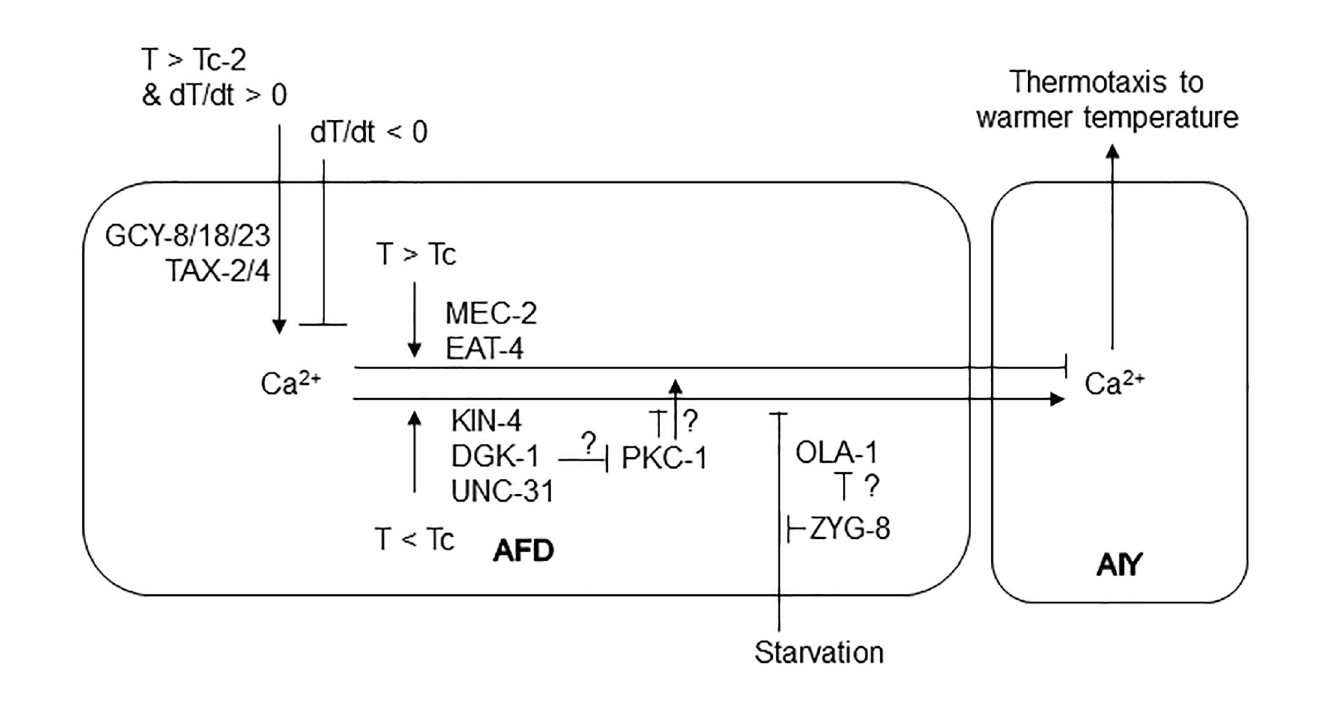
Fig 9. Mechanisms underlying AFD-AIY synchrony. Ca 2+ level in AFD increases upon warming above a threshold temperature that is determined by cultivation temperature (Tc) in a manner dependent on guanylyl cyclases (GCYs) and TAX-2/4 CNG channels [93,94];and decreases upon cooling. In well-fed animals, Ca 2+ level in AIY increases synchronously with that in AFD when the ambient temperature is lower than the cultivation temperature (T < Tc) but decreases when T > Tc. Starvation disrupts the synchrony.